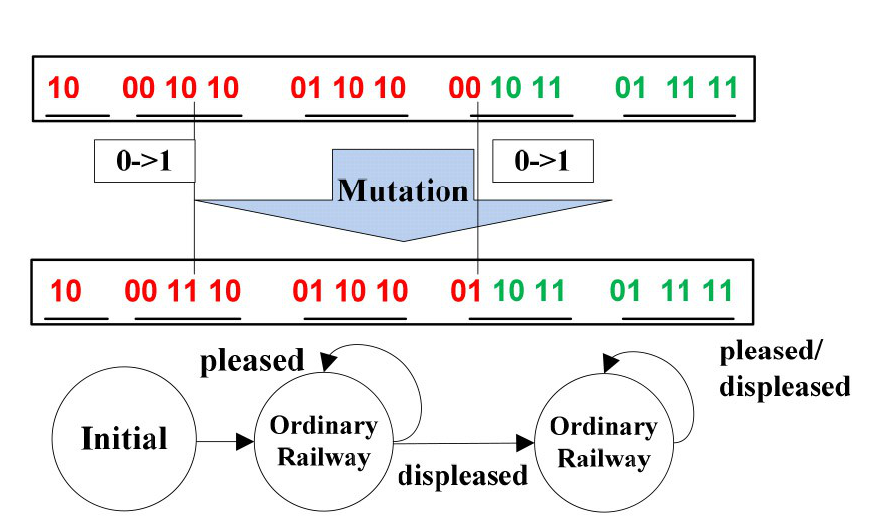
Figure 4. The Mutation Mechanism of Passenger